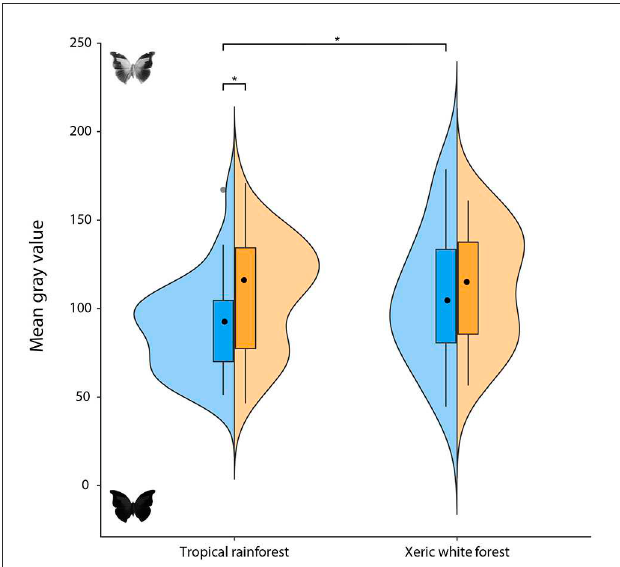
FIGURE1 Mean gray value of butterflies from two biomes (tropical rainforest and xeric white forest). Blue and orange violin areas represent the frequency distribution of values for the dorsal and the ventral sides of butterflies’ wings, respectively. Boxes indicate interquartile ranges, whiskers show 95% confidence intervals, and median values are represented by black dots. Gray dots represent outliers, while asterisks and brackets indicate statistically significant differences. The lower the mean gray value, the greater the melanism exhibited.